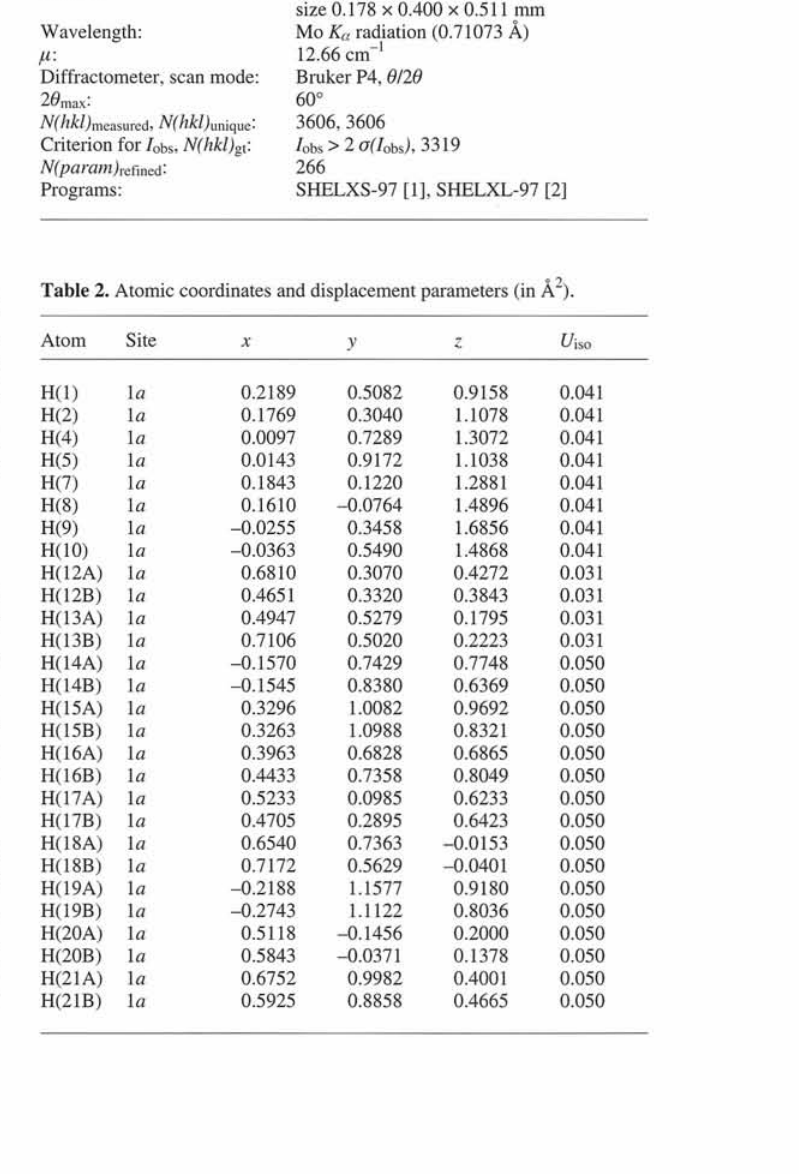
Table 1. Data collection and handling.